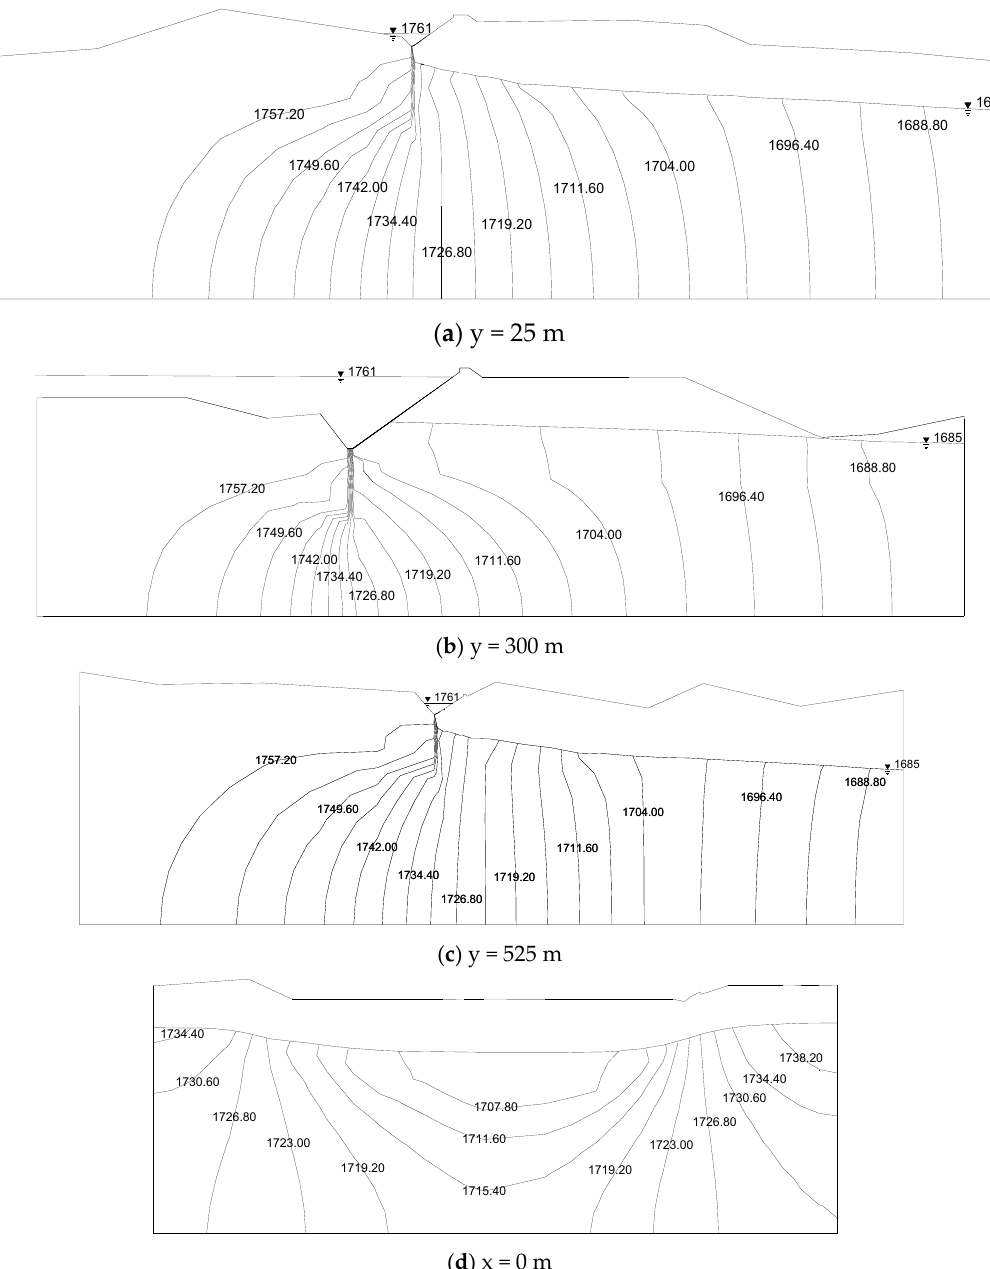
Figure 12. Groundwater potential map of the Hami concrete-face rockfill dam under HM-1. The unit of water level in the figure is in meter.